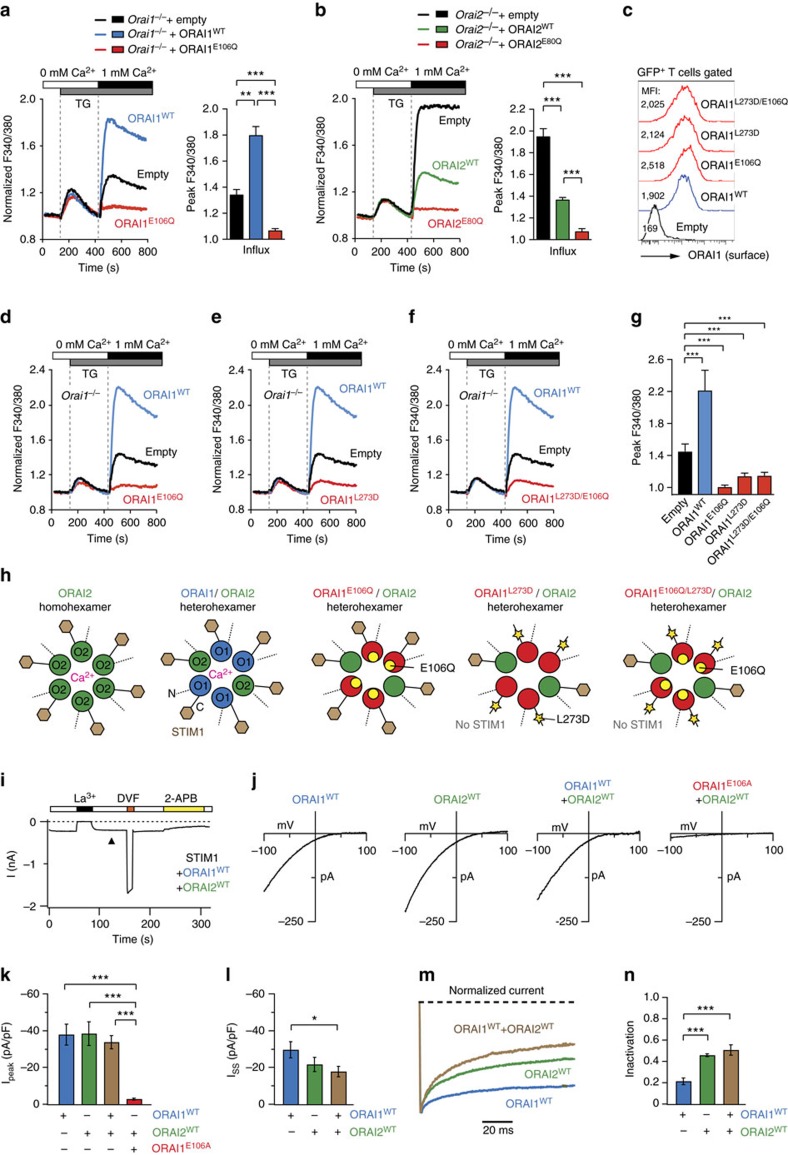
ORAI1 and ORAI2 form heteromeric channels.(a) Analysis of SOCE in Orai1-deficient T cells transduced with empty vector (EV), wild type ORAI1 (ORAI1WT) or a pore-dead ORAI1 mutant (ORAI1E106Q). Transduced GFP+CD4+ T cells were FACS sorted and SOCE was analysed following thapsigargin (TG) stimulation and addition of 1 mM extracellular Ca2+. (b) Analysis of SOCE in Orai2-deficient T cells transduced with EV, ORAI2WT or a pore-dead ORAI2 mutant (ORAI2E80Q). GFP+CD4+ T cells in a,b were analysed for SOCE (peak F340/380); shown are means±s.e.m. of cells from three mice measured in triplicates. (c) Surface expression of ectopically expressed ORAI1 mutants used in d–g using an anti-ORAI1 (2C1.1) antibody by flow cytometry. (d–g) Analysis of SOCE in Orai1-deficient T cells transduced with (d) EV, ORAI1WT, ORAI1E106Q, (e) the STIM1 binding-deficient ORAI1L273D mutant and (f) the ORAI1L273D/E106Q double mutant as described in a. (g) Quantification of SOCE (peak F340/380) as shown in d–f; means±s.e.m. of cells from four mice measured in triplicates. (h) Illustration how E106Q and/or L273D mutations affect formation and function of ORAI1:ORAI2 heteromeric channels. (i) Time course of CRAC currents in HEK293 cells overexpressing YFP-ORAI1WT and CFP-ORAI2WT together with STIM1 and stimulated with 1 μM TG. Extracellular La3+ (150 μM) and 2-APB (50 μM) inhibit the currents in Ringer's solution containing 20 mM Ca2+. Application of DVF solution reveals large Na+ currents. (j) Representative I–V relationships of ORAI channels. (k) Summary of peak CRAC current amplitudes measured during step pulses to −100 mV in cells expressing the indicated ORAI isoforms. Eight to nine cells per condition were analysed. (l) Summary of steady-state (SS) CRAC current amplitudes in cells expressing ORAI isoforms at the end of a 100 ms pulse to −100 mV. (m) ORAI1:ORAI2 channels exhibit enhanced fast CDI. Traces depict currents recorded during hyperpolarizing voltage steps to −100 mV. Currents were normalized to their peak values. (n) Summary of fast inactivation during the 100 ms pulse measured as: 1−Iss/Ipeak, where Ipeak and Iss are the peak and steady-state currents during the pulse to −100 mV. k,l,n are means±s.e.m. *P<0.05; **P<0.005; ***P<0.001 in (a,b,g,k,l,n) using unpaired Student's t-tests.